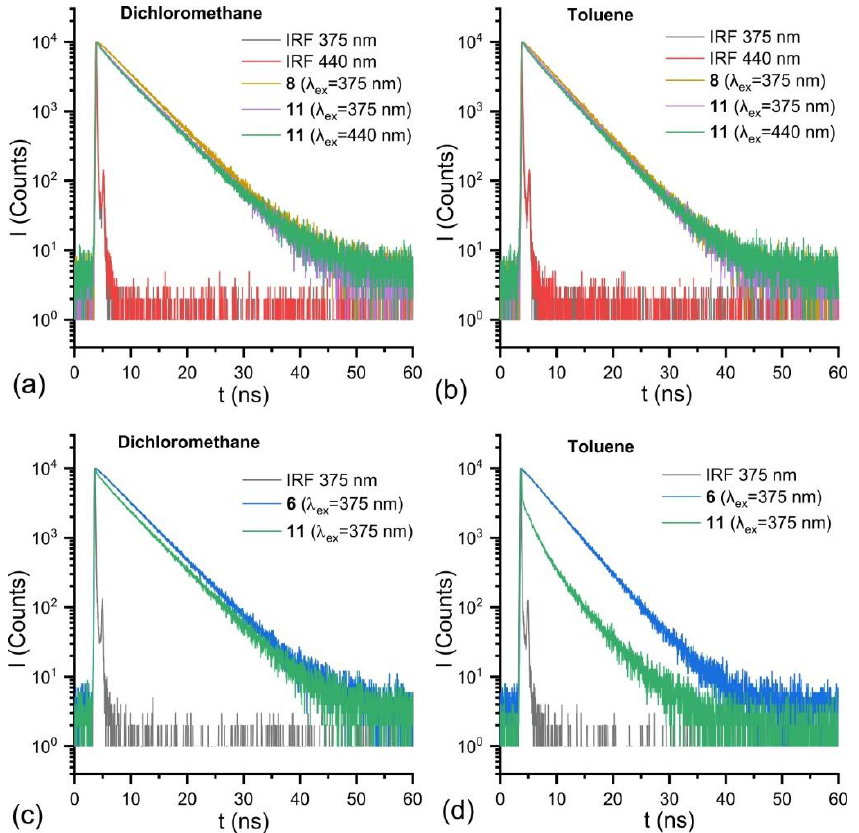
Figure 4. Fluorescence decay kinetics of compound 8 and 11 in dichloromethane ( a ) and toluene ( b ) obtained at 511 nm and for compounds 6 and 11 in dichloromethane ( c ) and toluene ( d ) measured at 431 nm (excitation wavelengths are written in the corresponding figures).